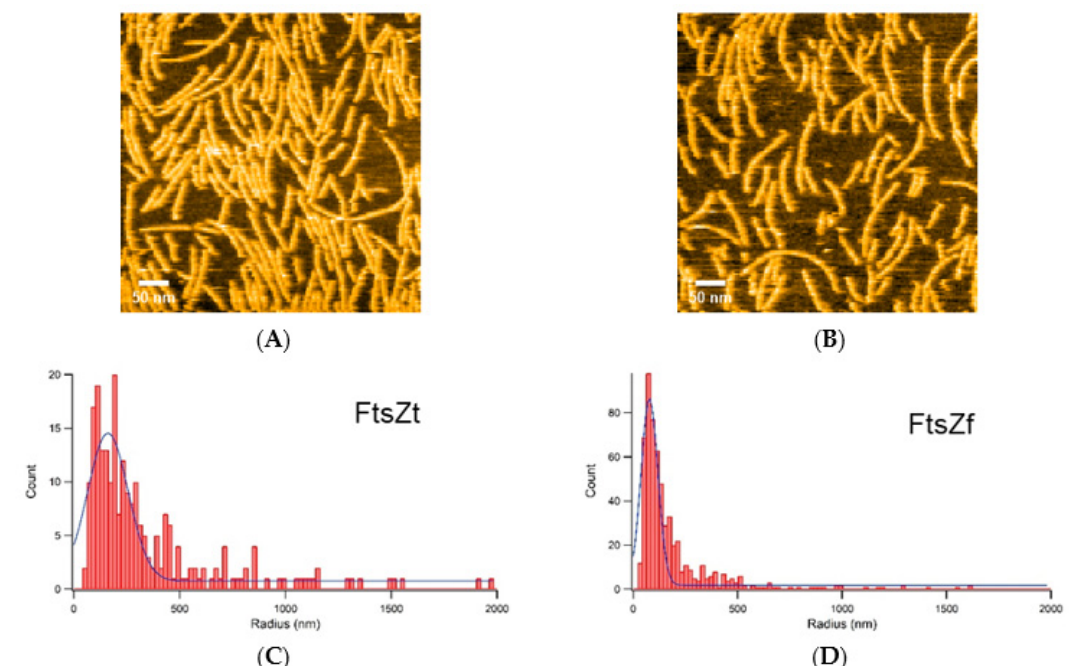
Figure 5. Curvature analysis of FtsZt and FtsZf filaments: ( A , B ) An image of FtsZf filaments taken under the following conditions: ( A ) 100 nM FtsZf and 600 μ M GTP; ( B ) 100 nM FtsZf, 600 μ M GTP, and 6 mM GDP; ( A , B ) show different fields of view; ( C , D ) Histograms of radius calculated by regarding the FtsZt ( C ) and FtsZf ( D ) filaments as arcs. Scale bars: 50 nm.